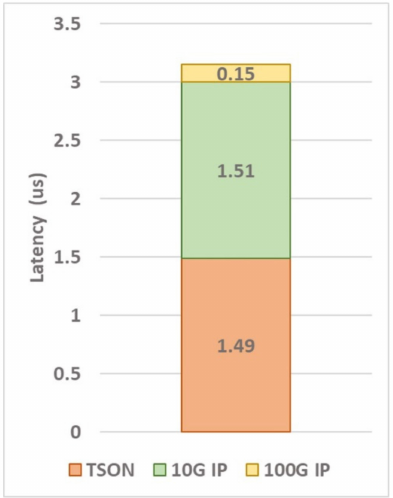
Figure 15. Performance evaluation: latency for one TSON edge node components. IP: intellectual property.